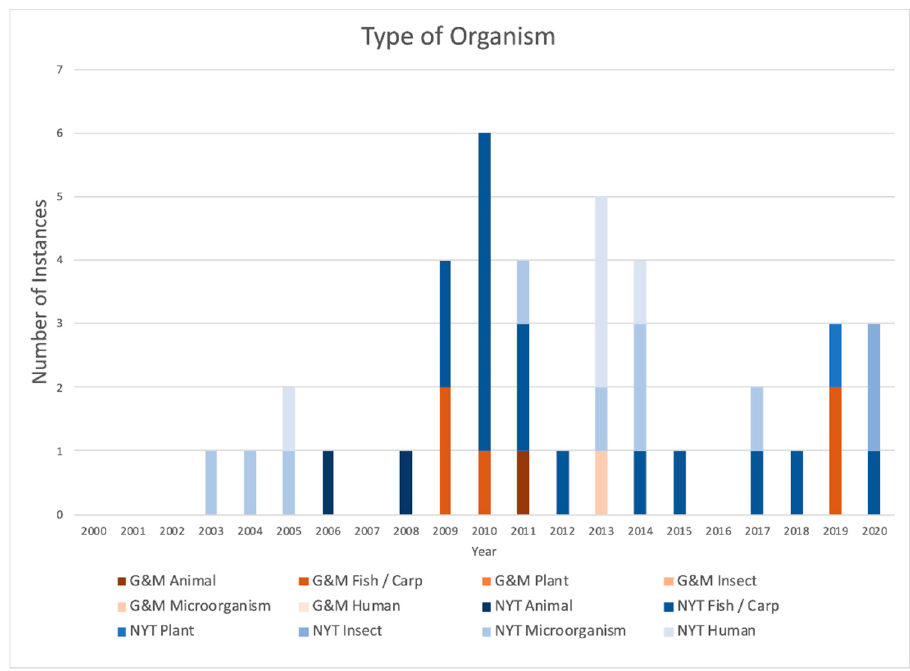
Figure 2. Type of organism referenced in conjunction with eDNA in the G&M and NYT ,